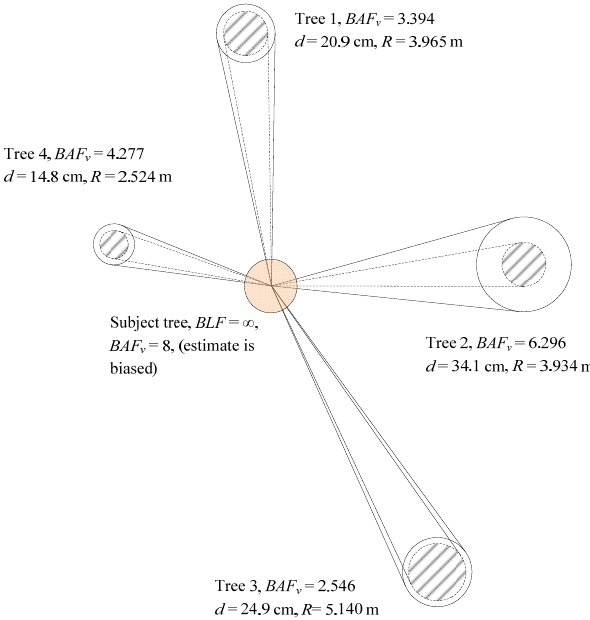
Figure 3. Conceptual figure demonstrating calculations of new estimator. Each competing tree is assigned a variable basal area factor ( BAF V ) depending upon its size and distance to the subject tree.